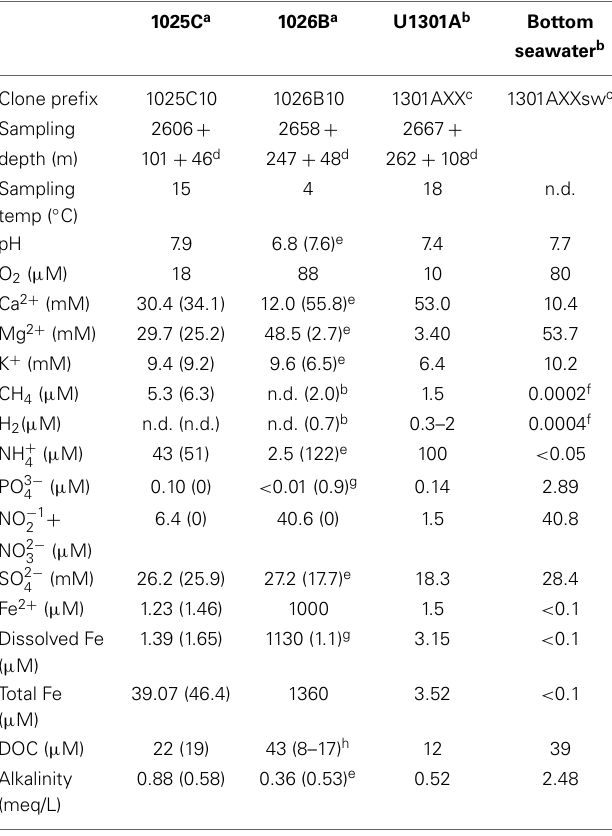
Table 1 | Characteristics of fluid samples collected from Holes